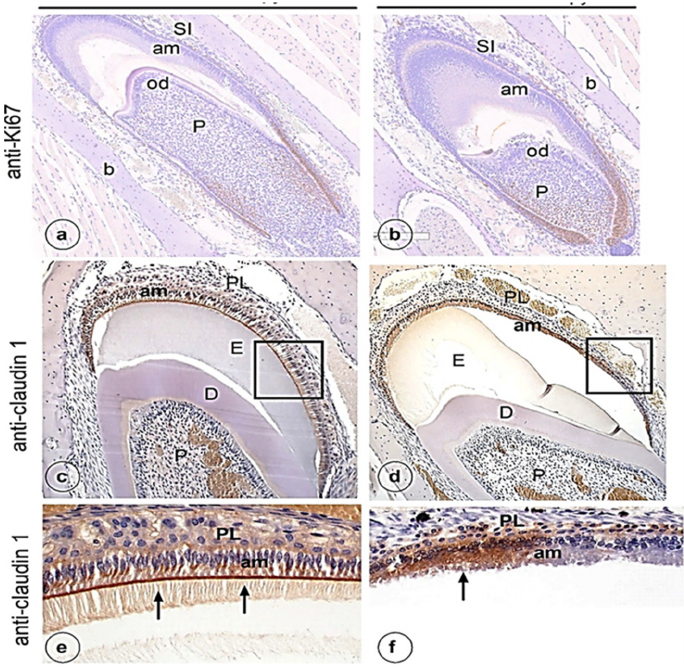
Figure 2. Ki-67 ( a , b ) and Claudin-1 ( c – f ) immunostaining of ameloblasts from mandibular incisor in control ( a , c , e ) and experimental mice ( b , d , f ): PL, papillary layer; P, pulp; am, ameloblasts; D, dentin; E, enamel; b, bone; SI, stratum intermedium. Cl cervical loop.